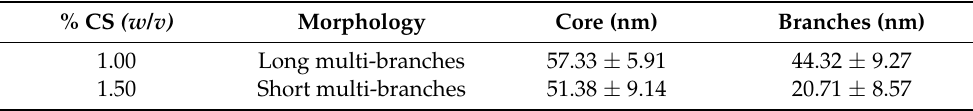
Figure 2. TEM images of GNS prepared in 1.0% ( a ) and 1.5% CS ( b ). Table 2. The influence of mass concentration of chitosan on the morphology, average core and branches of GNS.